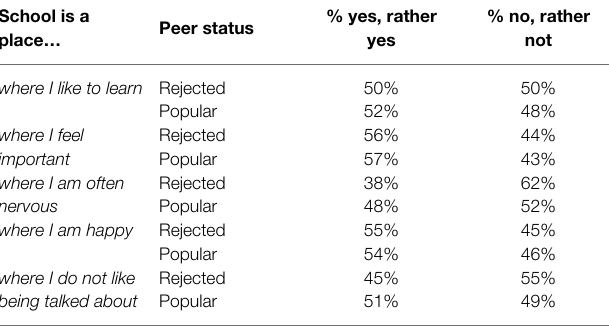
TABLE 1 | Intrapersonal response rates for rejected and popular students. School is a place…